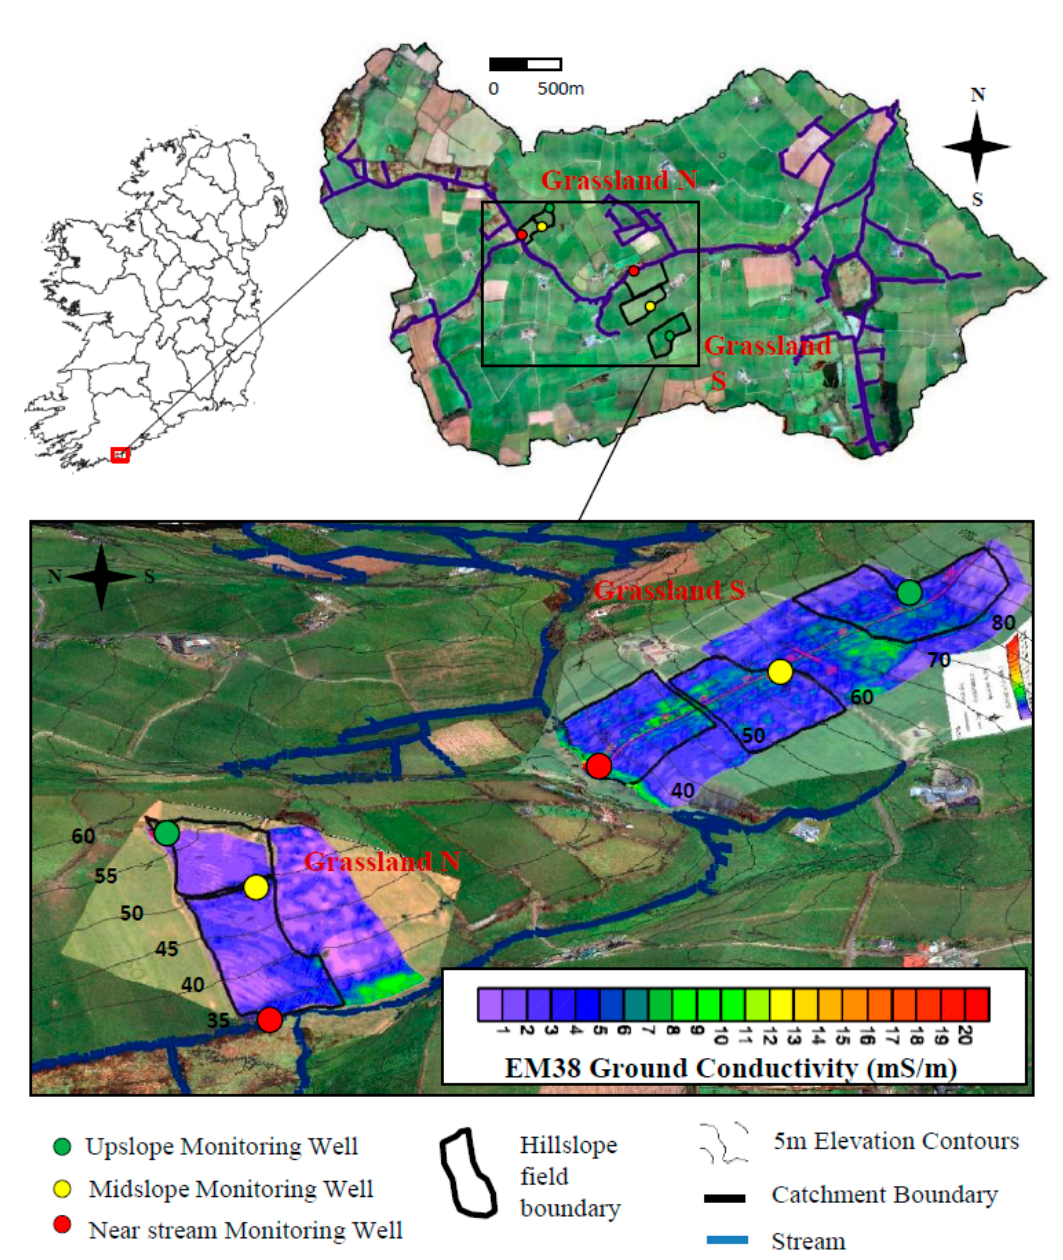
Figure 1. Grassland catchment area, hillslope field boundaries & monitoring wells and orthoimagery/electromagnetic ground conductivity (EM38) survey digitally grafted onto a catchment digital elevation model. High EM38 ground conductivity represents less permeable overburden, i.e., clay and/or waterlogged soil. The black field boundaries represent the areas where field specific agronomic information was available. Table 1. Soil physical and soil chemical